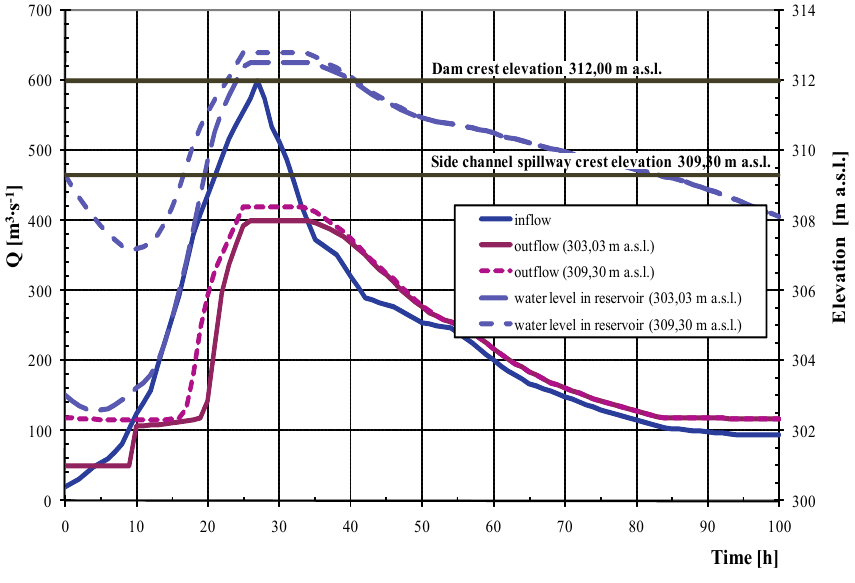
Fig. 5. Transformation of flood wave  Q for the existing reservoir outlet devices %1.0 (corrected spillway capacity ability), for the initial state of water levels in the reservoir at 303.03 and 309.30 m